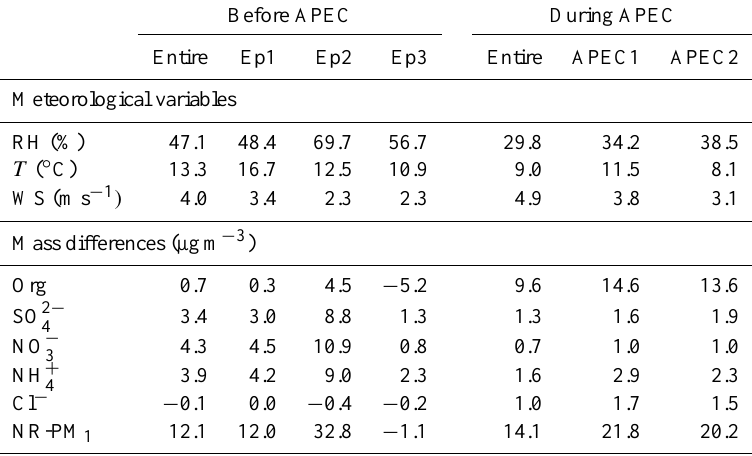
Table 1. Summary of average meteorological variables for different periods and the mass differences of aerosol species between the ground site and 260m (i.e., ground – 260m).